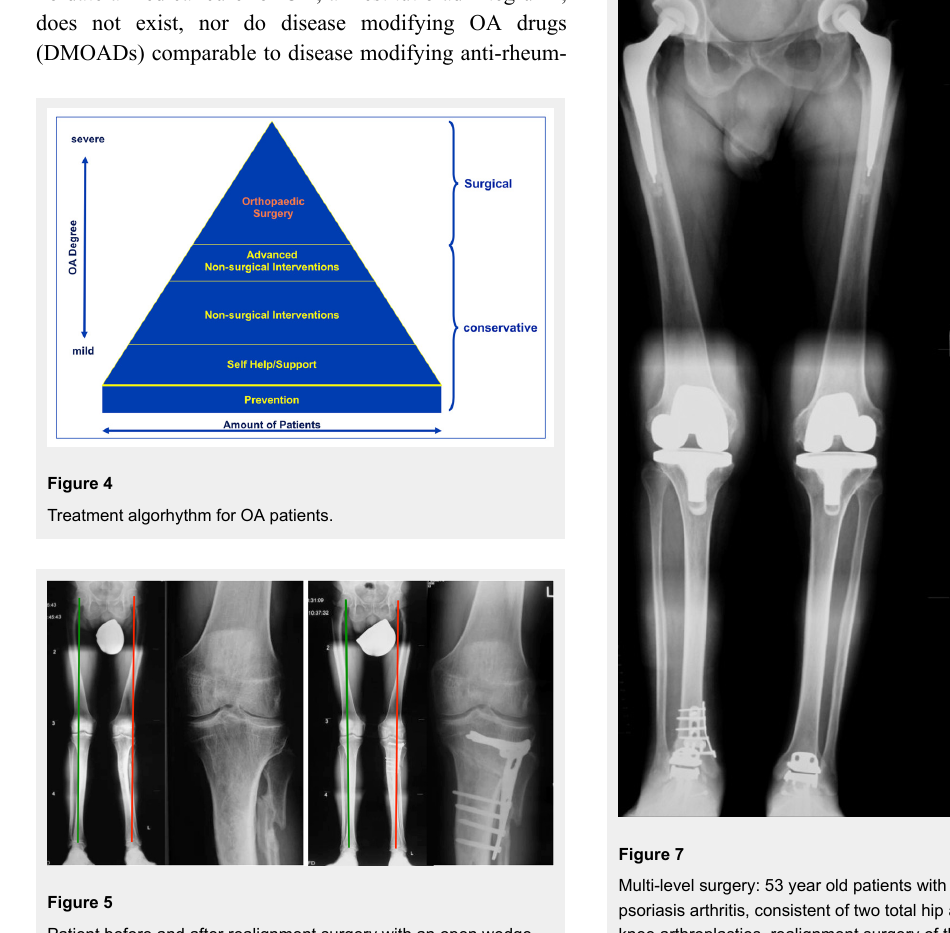
Patient before and after realignment surgery with an open wedge osteotomy of the proximal tibia.